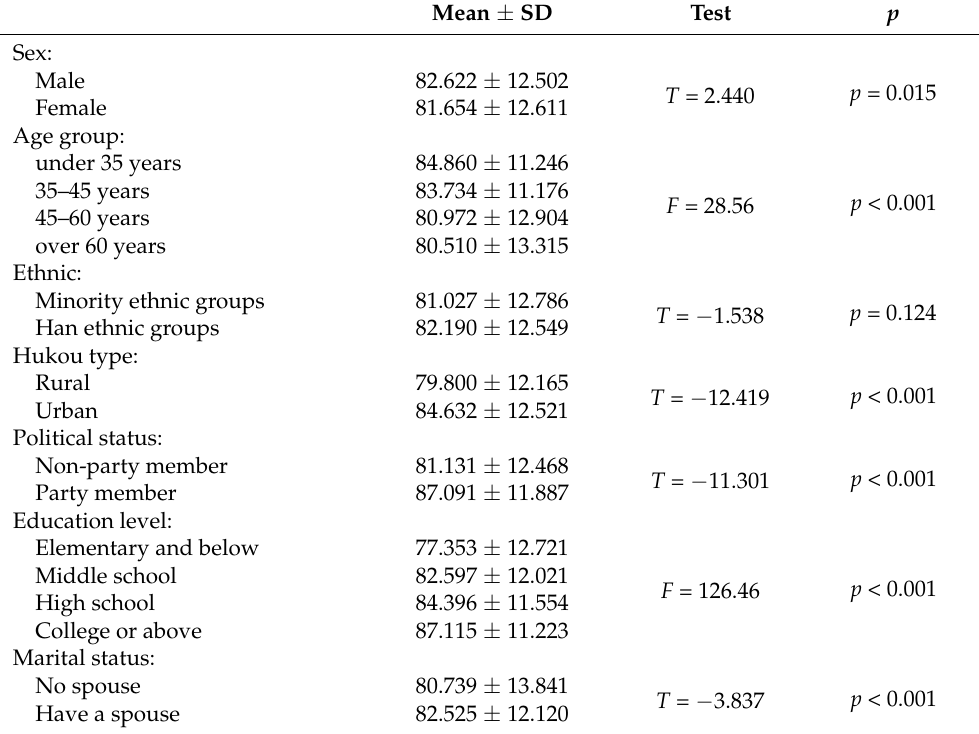
Table 2. Differences in subjective well-being of respondents with different characteristics (N = 4031).